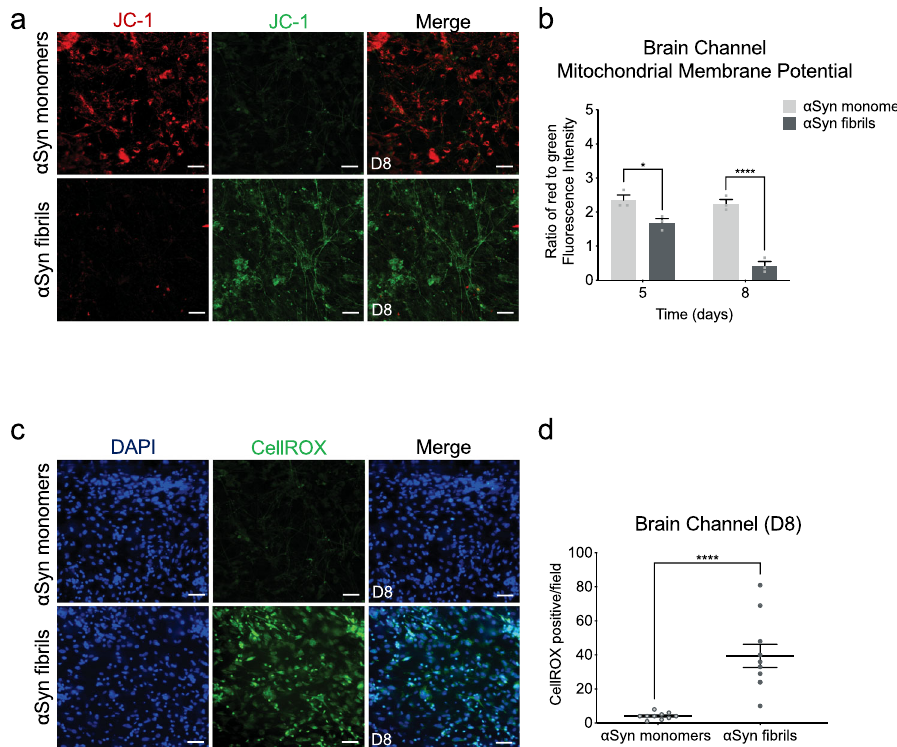
Fig. 4 Reduction of mitochondrial activity and increase in ROS production in the α Syn fi bril model. a Mitochondrial membrane potential assessed by JC- 1 staining in the brain side at day 6 post-exposure. Dual emission images (527 and 590 nm) represent the signals from monomeric (green) and J-aggregate (red) JC-1 fl uorescence. Scale bars: 100 μ m. b Quantitative analysis of the ratio of Red/Green fl uorescence intensity in each group at day 3 and 6 post- exposure (D5 and D8, respectively). Statistical analysis is two-way ANOVA with Tukey ’ s multiple comparisons test (n = 3 independent chips with 3 – 4 randomly selected different areas per chip, * P = 0.0389, **** P < 0.0001 compared to monomeric group). Error bars represent mean ± SEM. c Representative images of reactive oxygen species (ROS) levels (green, CellROX) show higher levels of intercellular ROS in the cells of the brain channel exposed to α Syn fi brils than those exposed to α Syn monomer at day 8 post-exposure. Scale bars: 100 μ m. d Quanti fi cation of the number of CellROX- positive events per fi eld of view in each group. Statistical analysis is two-sided unpaired t -test ( n = 3 independent chips with 3 – 4 randomly selected different areas per chip, **** P < 0.0001 compared to monomeric group). Error bars represent mean ±